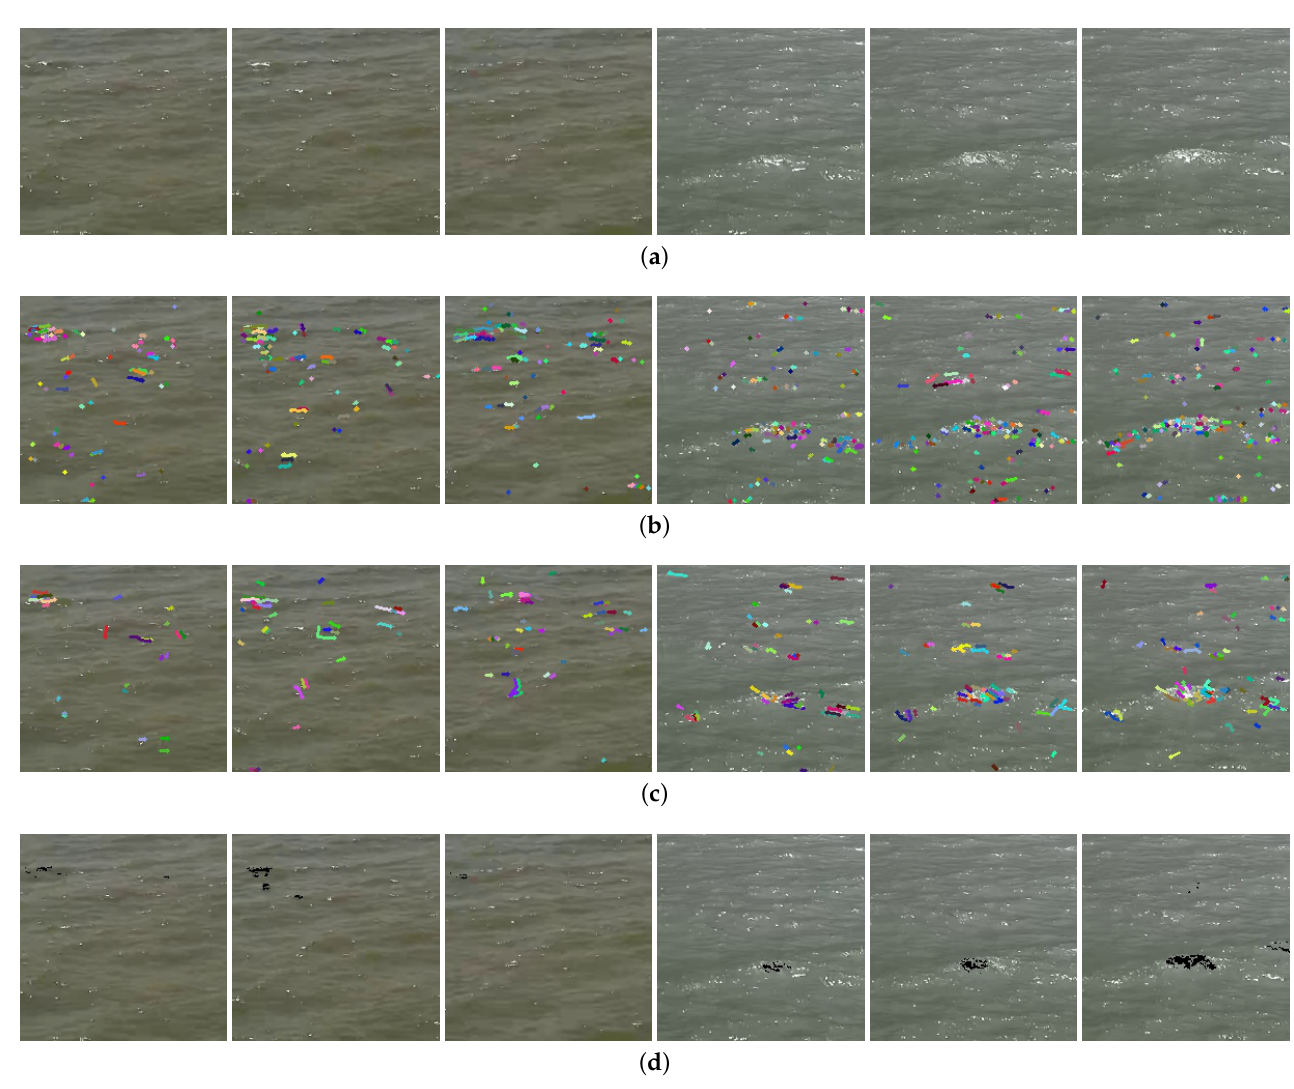
Figure 15. ( a ) Original images; ( b ) T h ; ( c ) T l ; and ( d ) false-positive areas caused by using only tracked